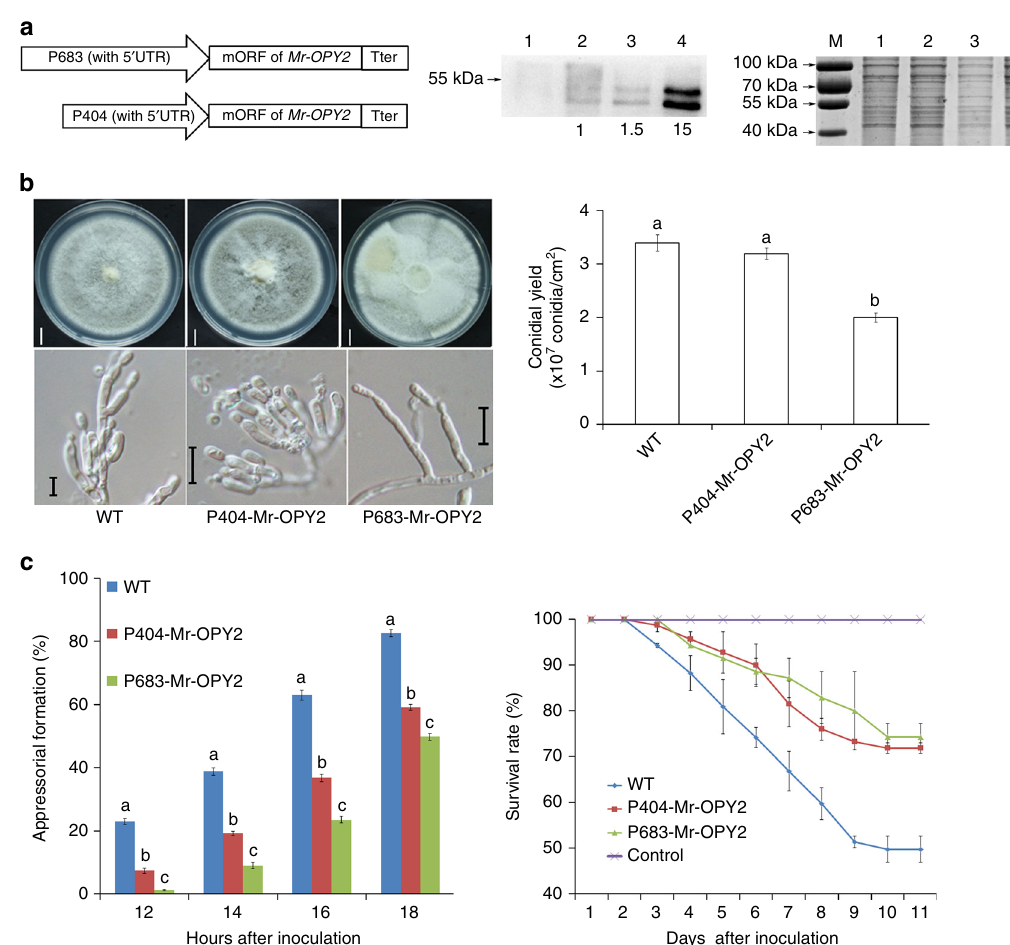
Fig. 4 Precise regulation of Mr-OPY2 levels is important for saprophytic growth and infection. a Constructing strains with manipulated Mr-OPY2 levels. Left panel: diagram illustrating constructs where Mr-OPY2 ’ s ORF is driven by the two Pgpd promoters, P683 and P404, with high and low activity, respectively. These constructs were transformed into Δ Mr-OPY2 to produce strains where the Mr-OPY2 level was exclusively controlled by the promoters. The 'With 5 ′ UTR' indicates the 5 ′ UTR of the M. acridum gpd gene is included. Middle panel: western blot analysis of Mr-OPY2 levels in the transformants: (1) Δ Mr-OPY2 ; (2) WT; (3) P404-Mr-OPY2; and (4) P683-Mr-OPY2 . Mr-OPY2 levels are calculated relative to the WT which is set at 1 . Δ Mr-OPY2 is a negative control. Right panel: a portion of the loading control gel (for the Western blot analysis in the middle panel) stained with Coomassie Brilliant Blue. M: Protein ladder. The uncropped images of the western blot and the SDS-PAGE gel are shown in Supplementary Fig. 13. b Colony phenotype (left upper panel), conidiophores (left lower panel) and conidial yields (right panel) of strains with different Mr-OPY2 levels. Note: strain P683-Mr-OPY2 with elevated Mr-OPY2 level relative to WT has a fl uffy colony with impaired conidiophores and reduced conidial yield. Colony pictures were taken 18 days after inoculation. Scale bar in the left upper panel represents 10 mm, left lower panel 10 μ m. In the right panel, values with different letters are signi fi cantly different ( n = 9, P < 0.05, Tukey ’ s test in one-way ANOVA). c Pathogenicity of strains with different Mr-OPY2 levels. Left panel: appressorial development on a hydrophobic surface. At each time point, values with different letters are signi fi cantly different ( n = 3, P < 0.05, Tukey ’ s test in one-way ANOVA). Right panel: survival curves of G. mellonella larvae infected by the WT, P404-Mr-OPY2 and P683-Mr-OPY2 . Control: insects treated with 0.01% Triton X-100 solution. Bioassays were repeated three times with 40 insects per repeat. Conidial yield and appressorium formation assays were repeated three times with three replicates per repeat. Data are expressed as the mean ± SE. Images are representative of at least three independent experiments for each of the Mr-OPY2 transcript in P683-Mr-OPY2 (driven by the promoter P683) is signi fi cantly higher ( t -test, P = 0.006) than expression driven by P404 (strain designated P404-Mr-OPY2 ), and the quantity of Mr-OPY2 protein in P683-Mr-OPY2 was ~ 8- fold higher than in either P404-Mr-OPY2 or WT (Fig. 4a). Three isolates were randomly selected from P404-Mr-OPY2 and P683- Mr-OPY2 colonies. As no intra-strain differences were found between the three isolates of each strain in any assay we provide representative data for a single isolate/strain.